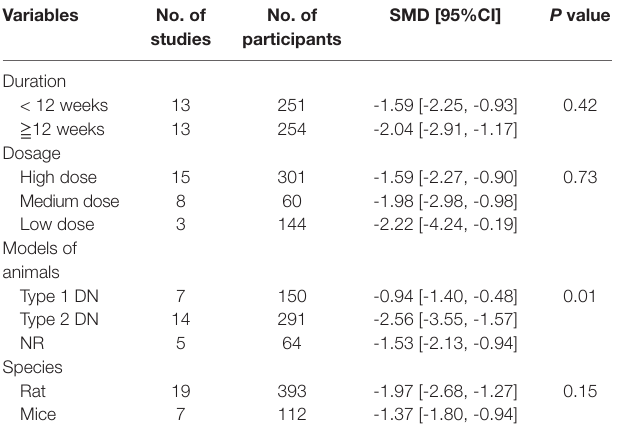
tABLe 4 | Subgroup analysis according to